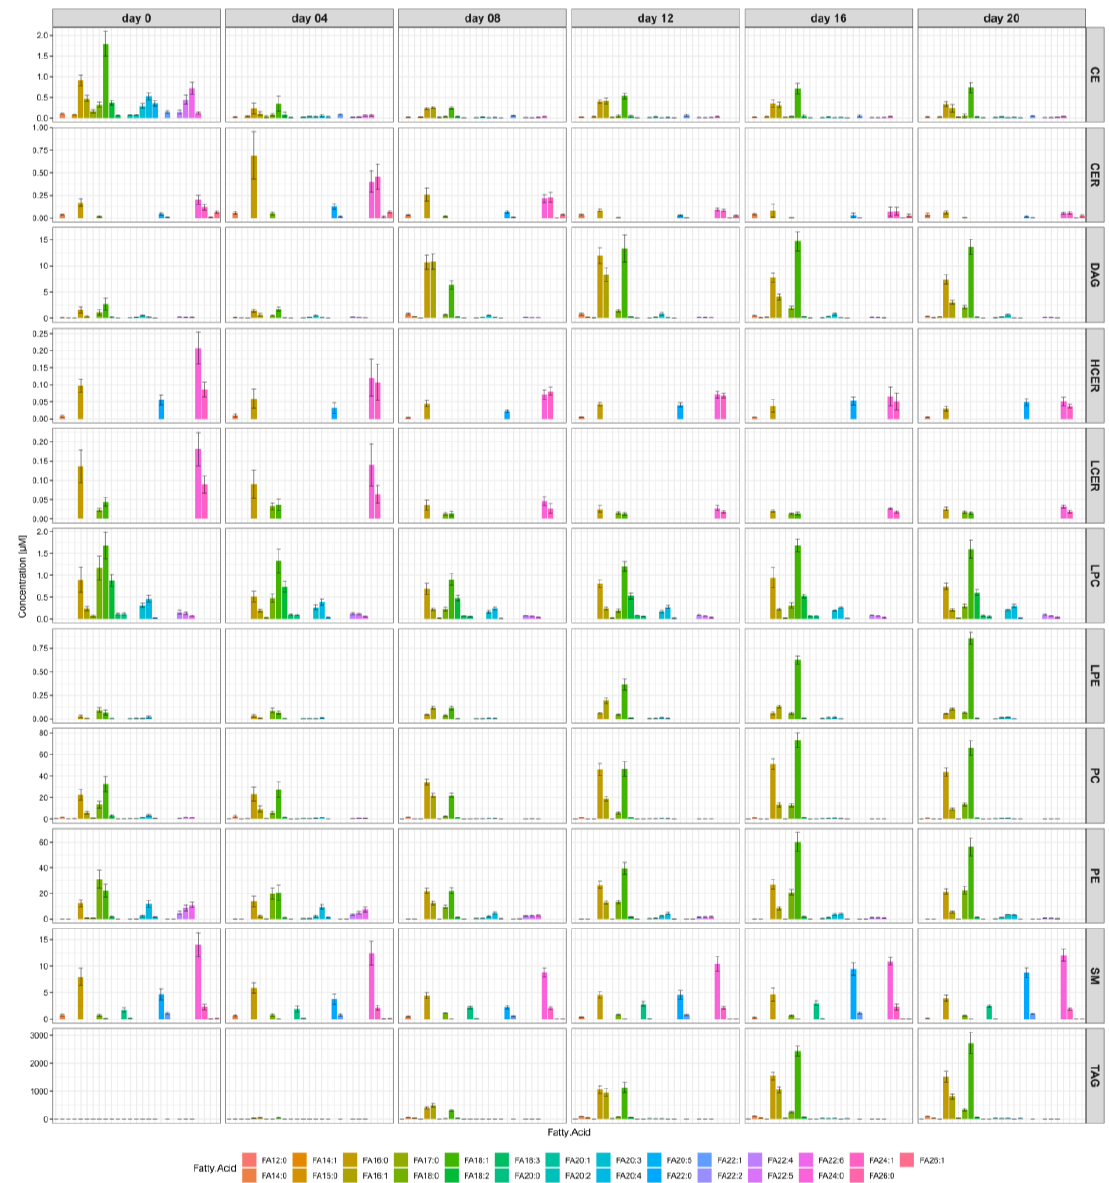
Figure 4. Fatty acid concentrations and compositions changed markedly during adipogenesis in all 11 lipid classes. At the start of differentiation, the lipids had a very heterogeneous side chain distribution with high concentration levels of LCFA and VLCFA. The concentrations of the VLCFA decreased during adipogenesis in all classes, with the exception of the class SM. The concentration courses of the LCFA were more complex because their levels increased markedly during adipogenesis within the classes DAG, LPE, PC, PE, and TAG, but decreased in the class CE. The FA concentration course of the SM differed strongly from the other classes because the VLCFA remained at high levels during